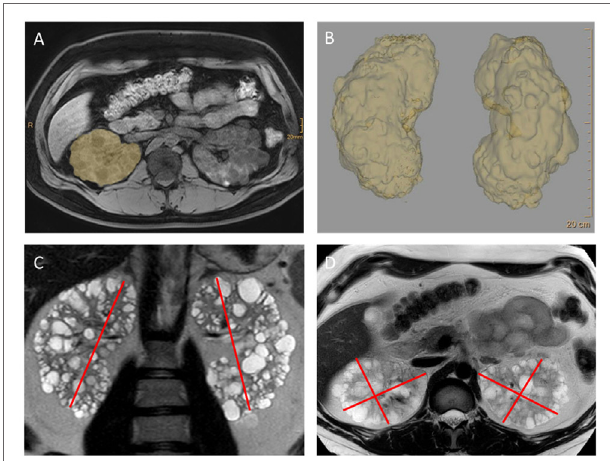
FiGURe 1 | MRI imaging and volumetry of kidneys in autosomal-dominant polycystic kidney disease (ADPKD). These images reveal the classical features of ADPKD: strongly enlarged kidneys showing a ubiquitous distribution of cysts throughout the parenchyma. Kidney volume—an important prognostic feature now used in algorithm for making treatment decisions—can be obtained by planimetry (A,B) as done in the clinical trials. However, for everyday clinical decisions volumetry based on measuring the axes and using the ellipsoid formula has been shown to be sufficient (19) (C,D) . From Müller et al. (27) (images kindly provided by Dr. Thorsten Persigehl, Institute of Radiology, University of